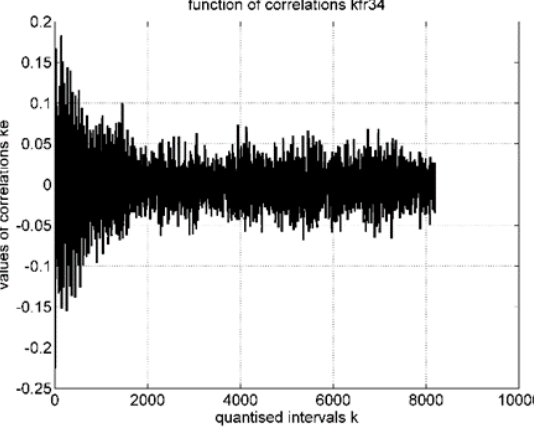
Figure 11. Normalized inter-covariance function of the 3th and 4th vibration accelerations vectors.